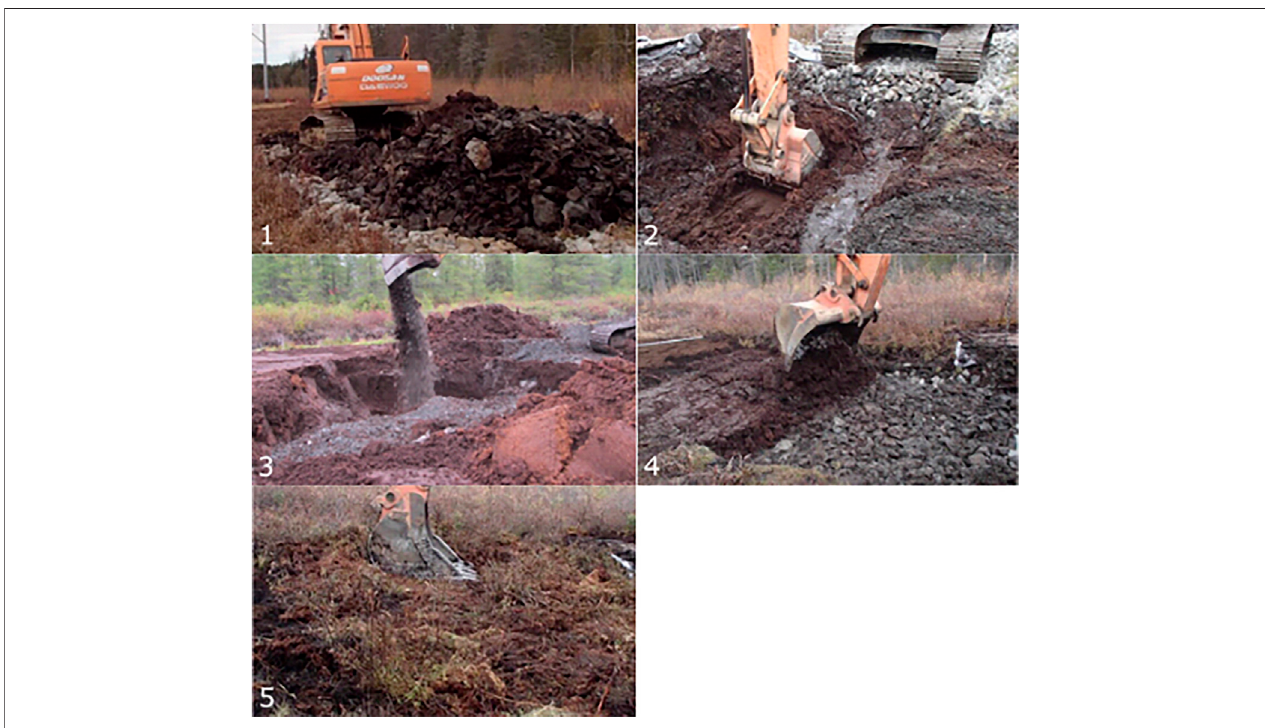
FIGURE2| StepsoftheBurialUnderPeatTechnique:1)excavationandstockpilingofthemineralmaterial,2)excavationoftheunderlyingpeat,3) fi llingthepitwith the mineral material, 4) covering the mineral material with excavated peat and leveling the soil surface with the adjacent peatland, and 5) revegetating of the peat surface with diaspores from adjacent